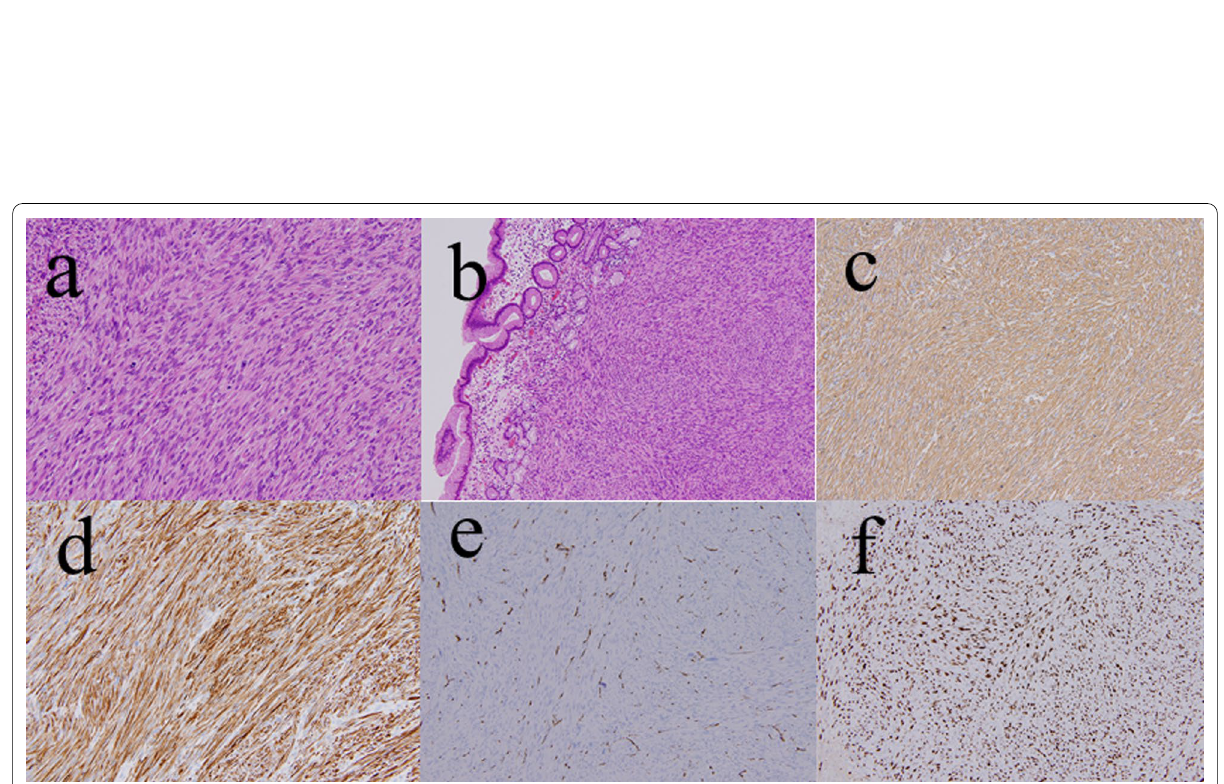
Fig. 3 Pathological findings. Hematoxylin and eosin staining shows well-developed fascicles of atypical spindle cells with eosinophilic cytoplasm ( a ) (200 ); derived from proper mucous membrane and submucosa ( b ) (100 ). Immunohistochemistry showed the tumor cells were positive for × × alpha-smooth muscle actin ( c ) (200 ), and desmin ( d ) (200 ), and negative for CD 34 ( e ) (100 ). Ki-67 index was estimated to be 60% ( f ) (100 × × ×